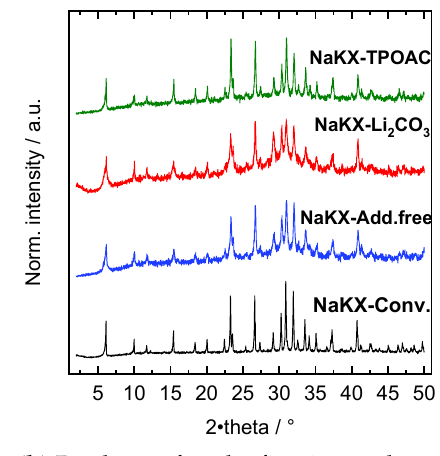
( a ) Products of the different synthesis routes. ( b ) Products after the first ion exchange.